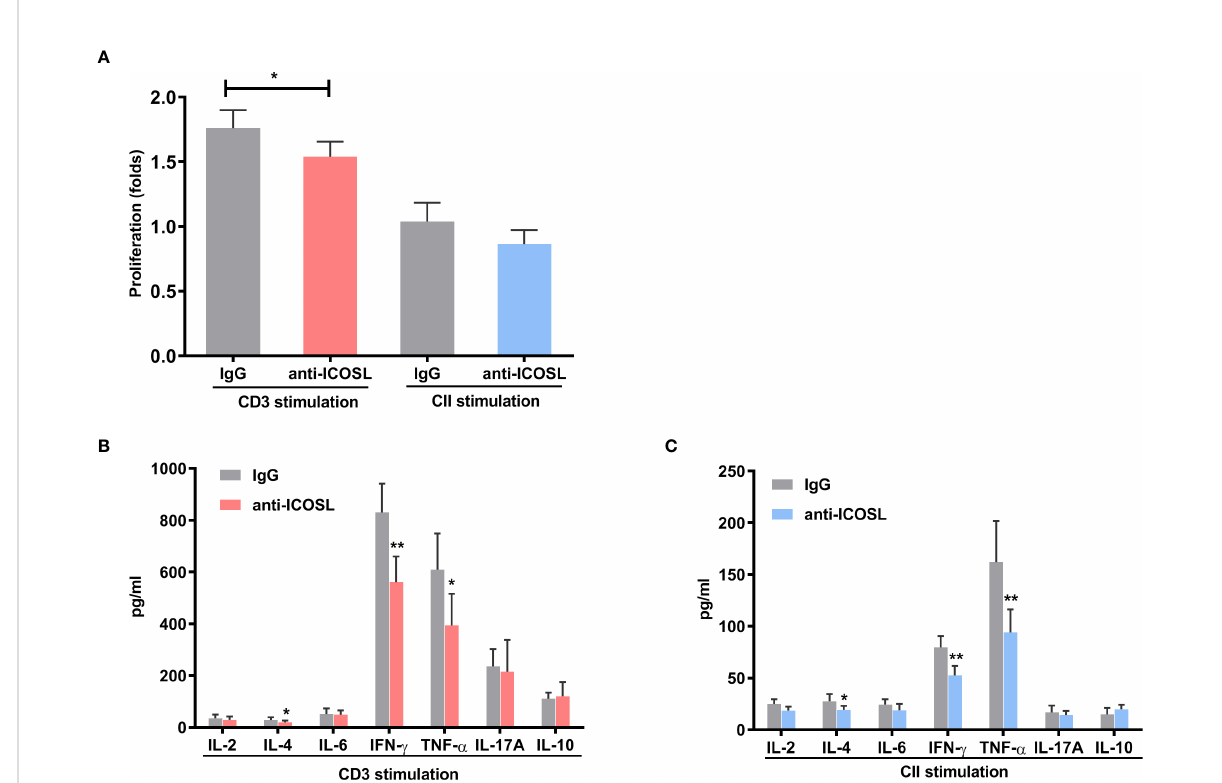
FIGURE 7 Blockade of ICOSL in vitro . (A) Cell proliferation in the CII- or CD3-stimulated splenocytes of CIA mice in the presence of anti-ICOSL mAb (5 m g/ ml, n = 5) or IgG (n = 5). (B, C) Cytokine secretion in the supernatants of CD3-stimulated or CII-stimulated splenocytes from CIA mice in the presence of anti-ICOSL mAb (5 m g/ml, n = 7) or in IgG controls (n = 7). Bars show mean ± SD; * P < 0.05, ** P <